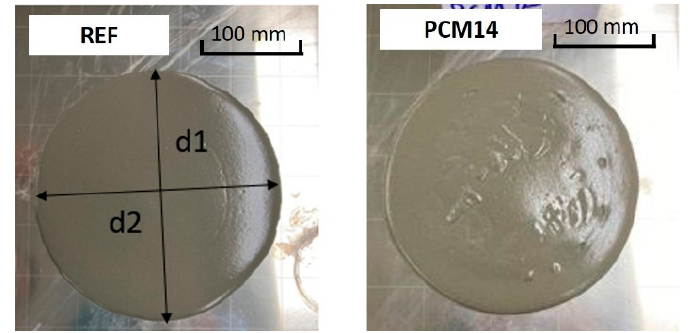
Figure 5. The slump flow of REF and PCM14.